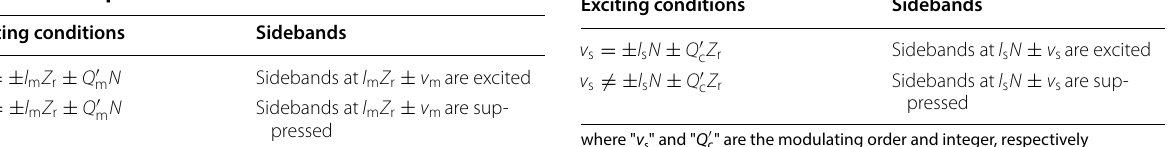
Table 4 Exciting conditions for sidebands excited by mesh excitations on